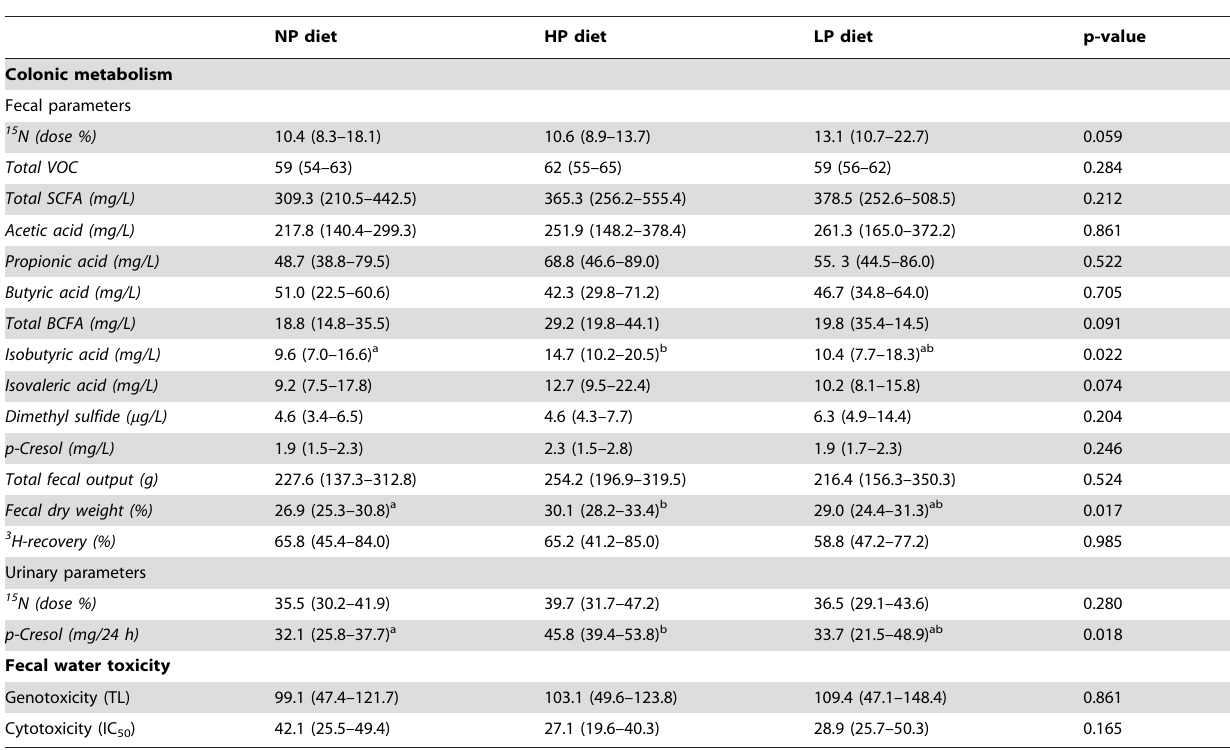
Table 2. Summary of the parameters of colonic metabolism and toxicity.